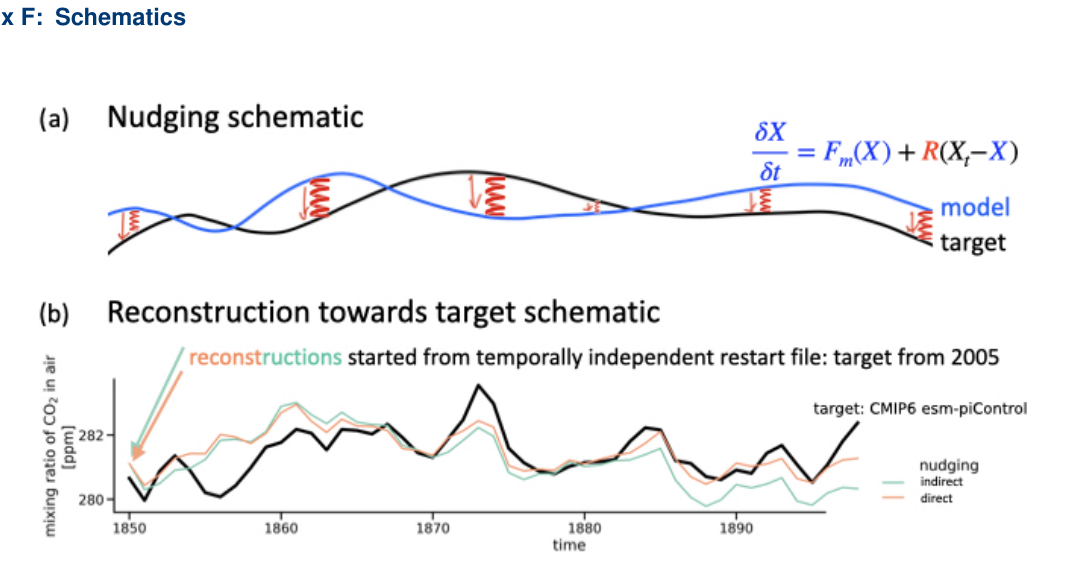
Figure F1. (a) Schematic of nudging with relaxation constant. (b) Schematic of reconstruction towards a target, where reconstructions are started from temporally independent restart files from the same simulation but 155 years later in time, i.e., 2005.